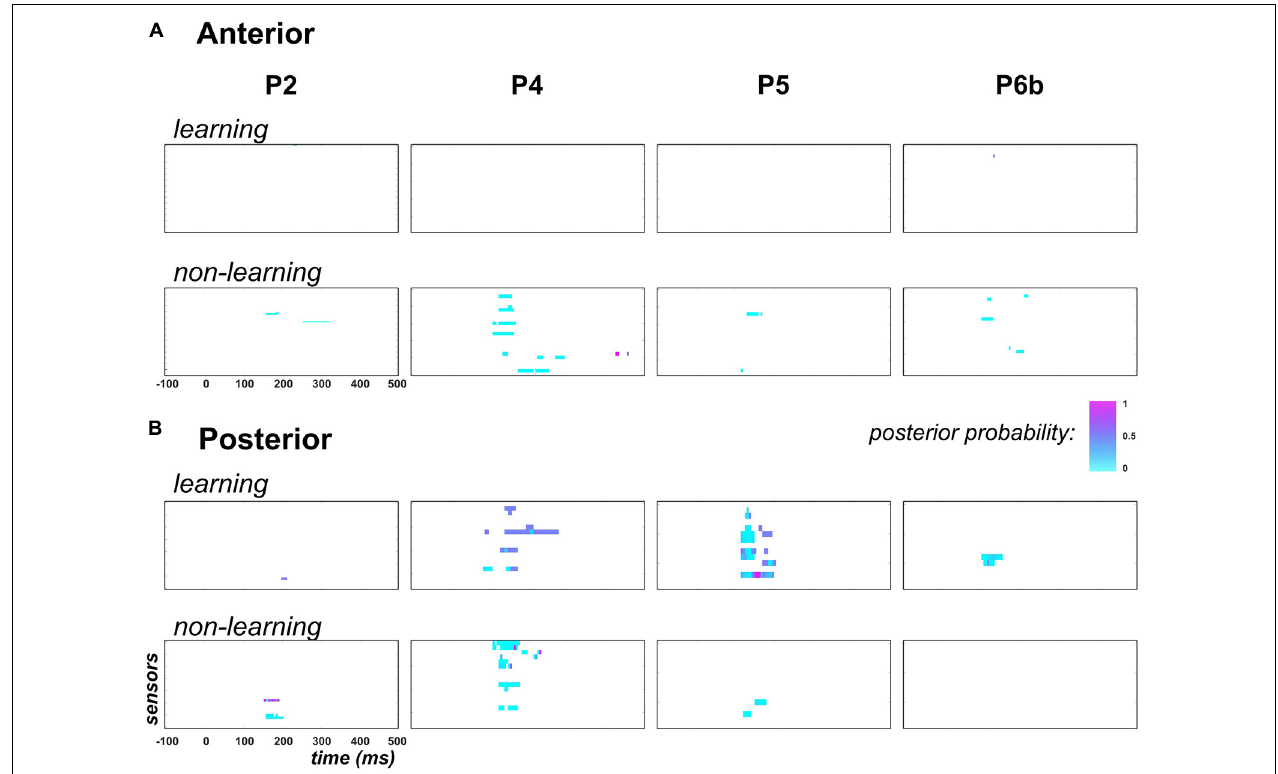
FIGURE 8 | Predictability findings (family-level inference in context PC). Following the display in Figure 6 , each individual map shows the posterior probability measured at each peri-stimulus time point over anterior (panel A ) and posterior (panel B ) temporal electrodes. In each panel, top row (learning) shows results for family τ = ON: posterior probability here indicates how likely parameter τ differs across contexts PC and UC. Bottom row (non-learning) present similar results applied to the non-learning regressor coefficients (h std static , h dev static ,h rank exp and h cs exp ). Family-level inference for each parameter was conducted only at data points for which an effect for this parameter was found in the GLM analysis (posterior probability threshold of 0.75). For the non-learning maps, in the specific case where multiple effects could occur at the same data point in the GLM analysis, we present the largest posterior probability across these